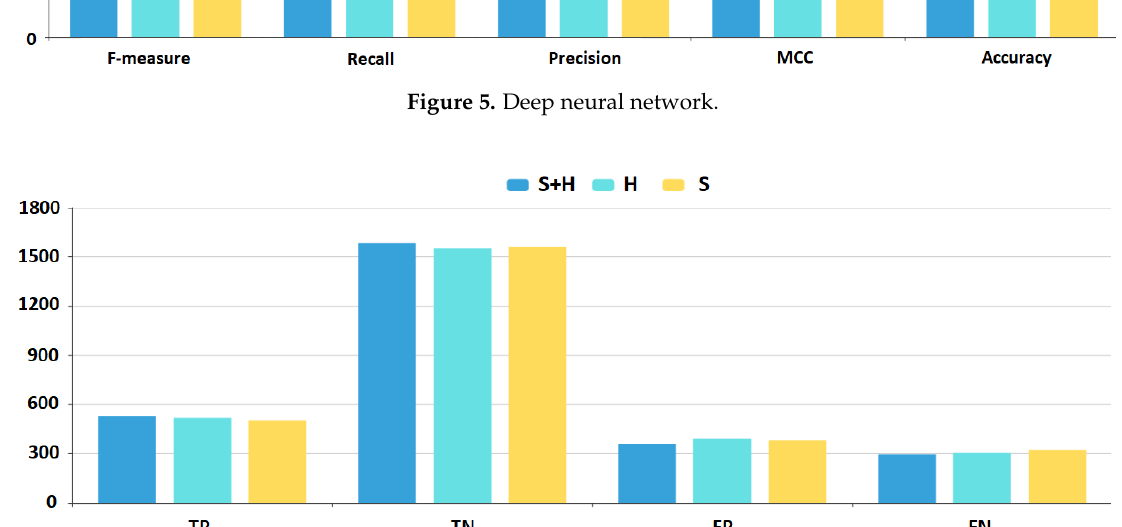
Figure 6. Deep neural